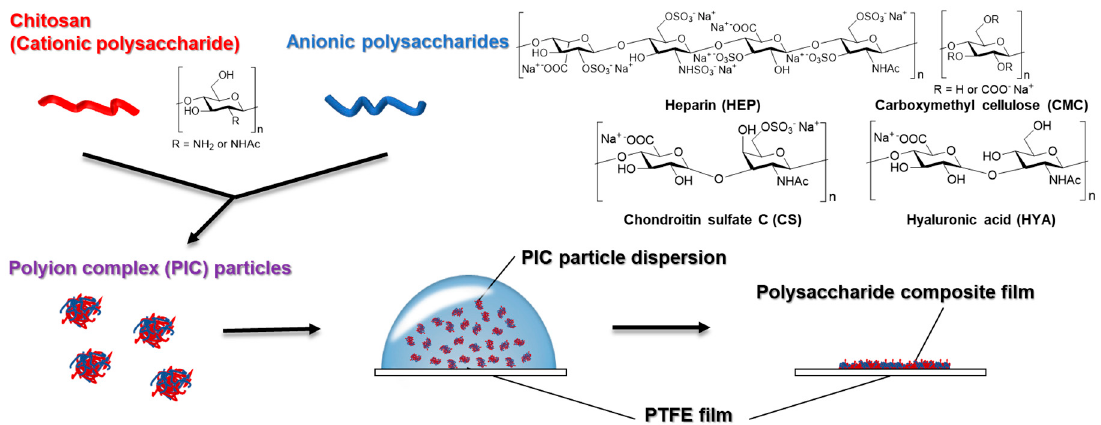
Figure 1. Schematic illustration of the preparation of polysaccharide composite films by casting and drying polyion complex (PIC) particle dispersion.